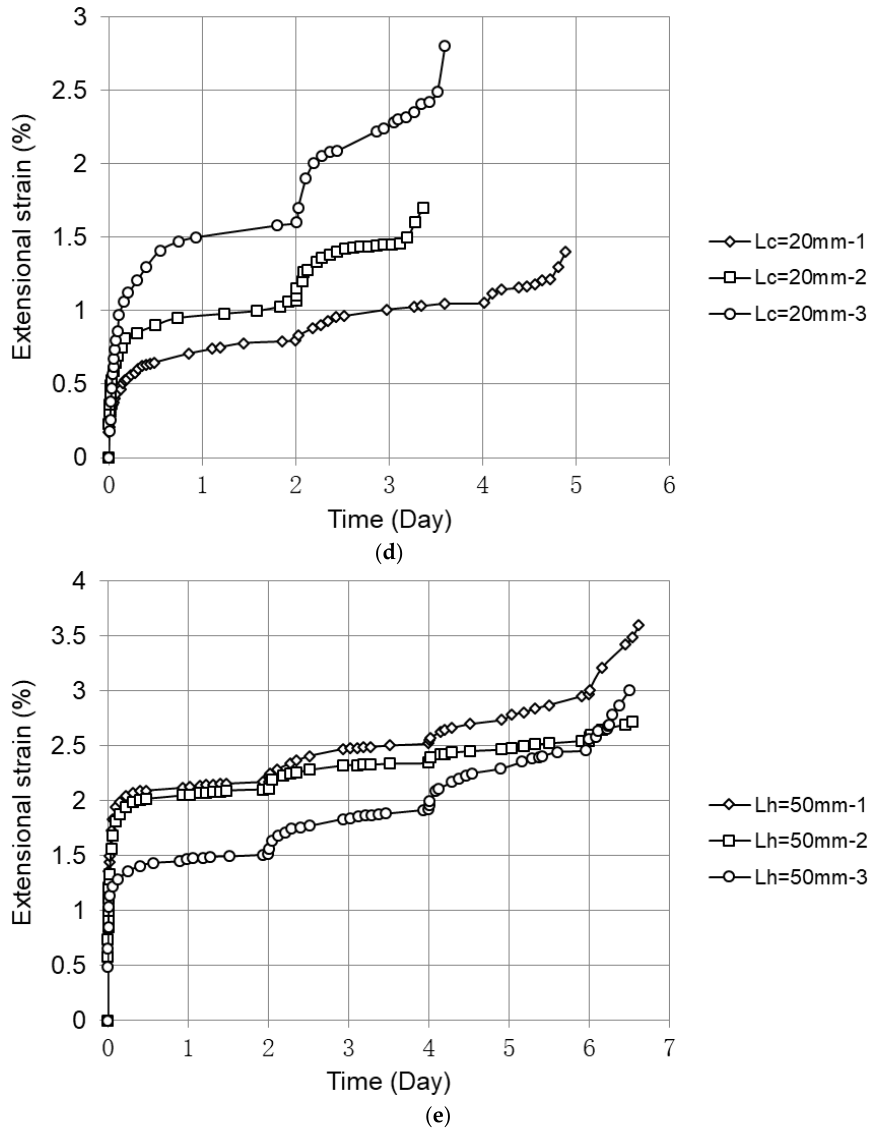
Figure 6. Extensional strain vs. time for the specimen with different crack depths at 20 °C by applying various step creep loadings, step loading every 2 days. ( a ) Water pressure: 100 – 150 – 200 kPa; ( b ) Water pressure: 100 – 120 – 140 kPa; ( c ) Water pressure: 100 – 120 – 140kPa; ( d ) Water pressure: 60 – 80 – 100 kPa; ( e ) Water pressure: 60 – 80 – 100 kPa